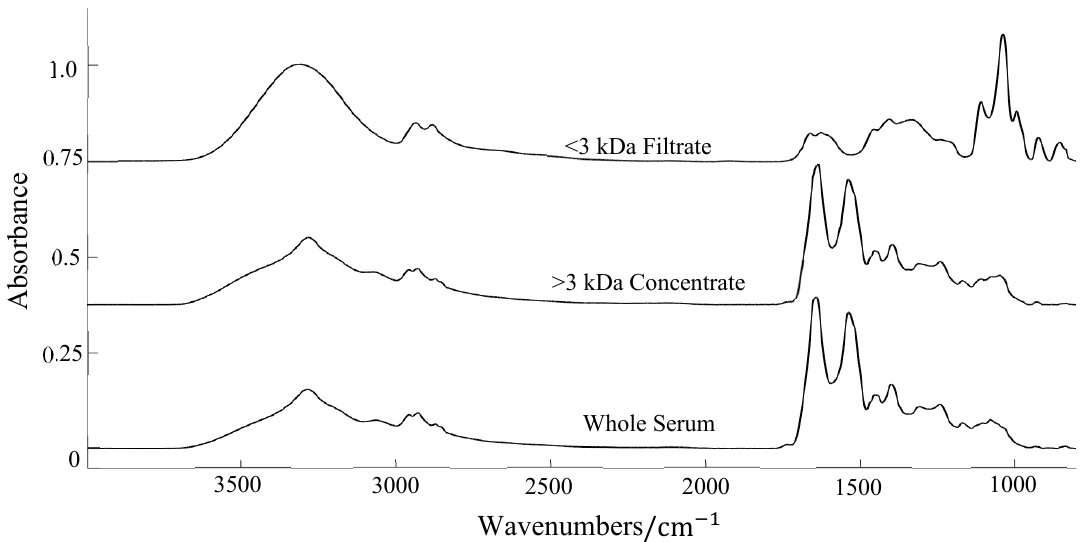
Figure 9. Examples of whole serum (bottom), the high molecular weight concentrate (middle) and the